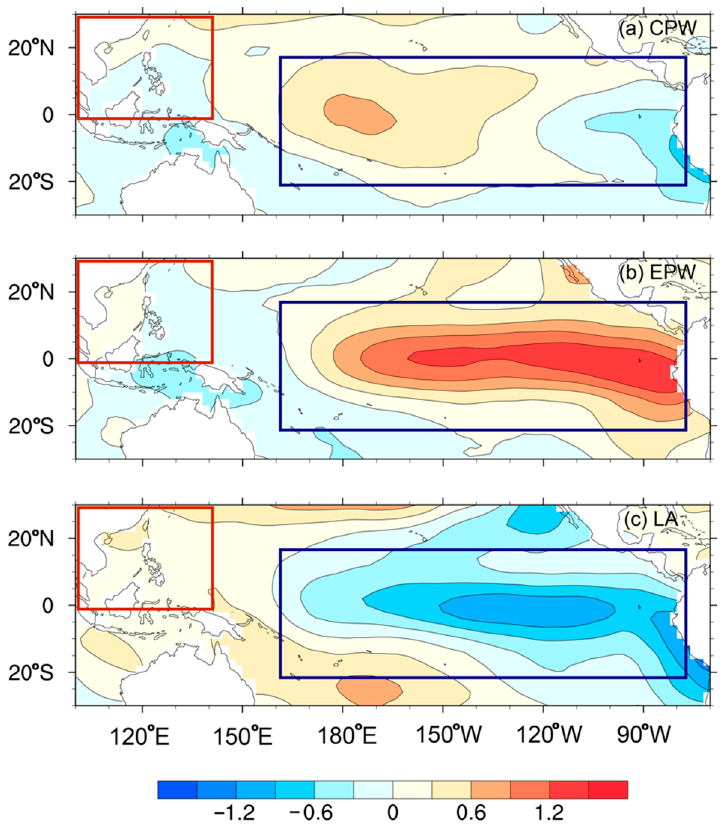
Figure 1. Composites of SSTA during the phase of ENSO for ( a ) CPW, ( b ) EPW, and ( c ) La Niña events (K).